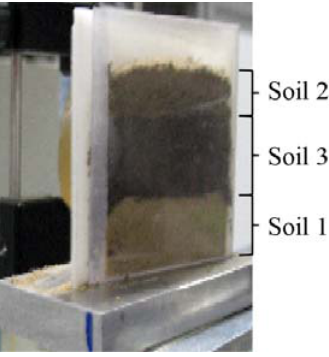
Figure 5. Wedge sample holder filled with three different soil samples. A transparent plastic wall material was used for the